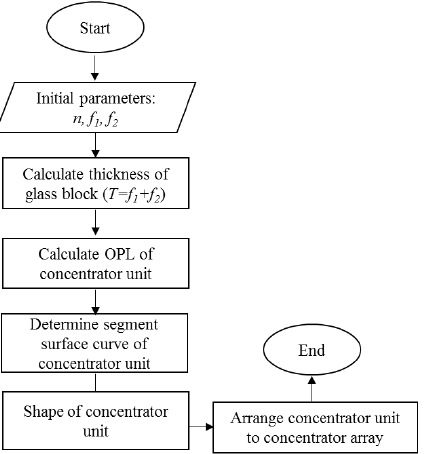
Figure 4. Design and analysis flowchart of the superposition compound eye-inspired primary con- Figure 4. centrator.